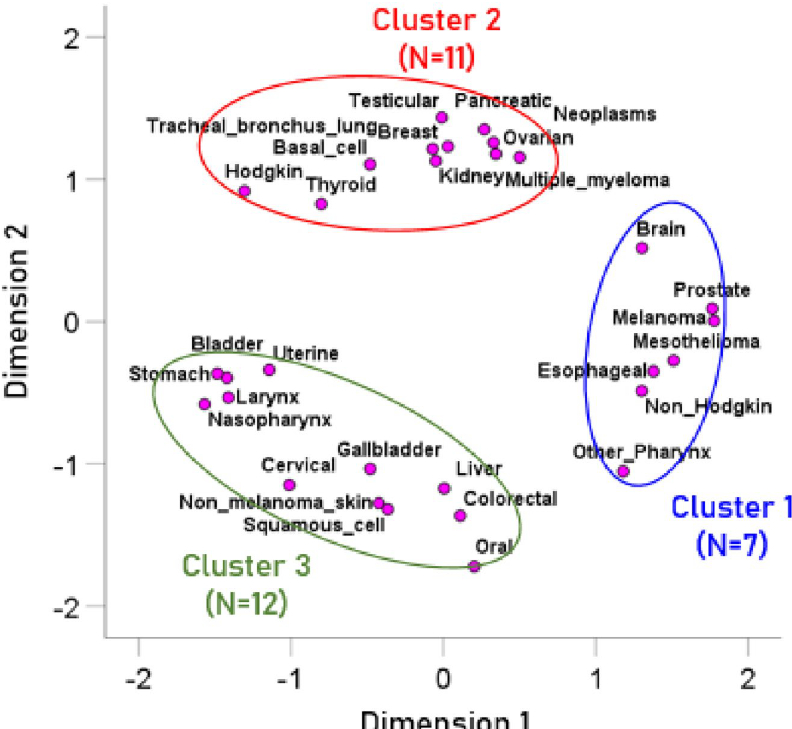
Figure 1. Multidimensional scaling (MDS) configuration map of the 30 cancer types with color-coded clusters of cancer types. Each point denotes the location of a cancer type within the 2-dimensional MDS